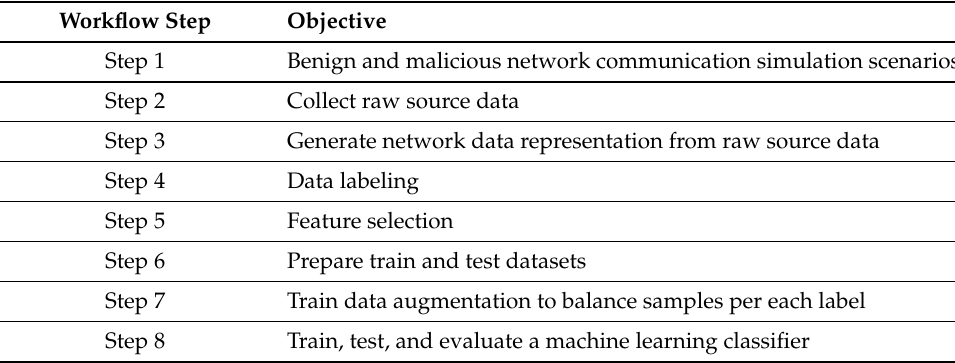
Table 3. Generic procedure to research cyber threat detection